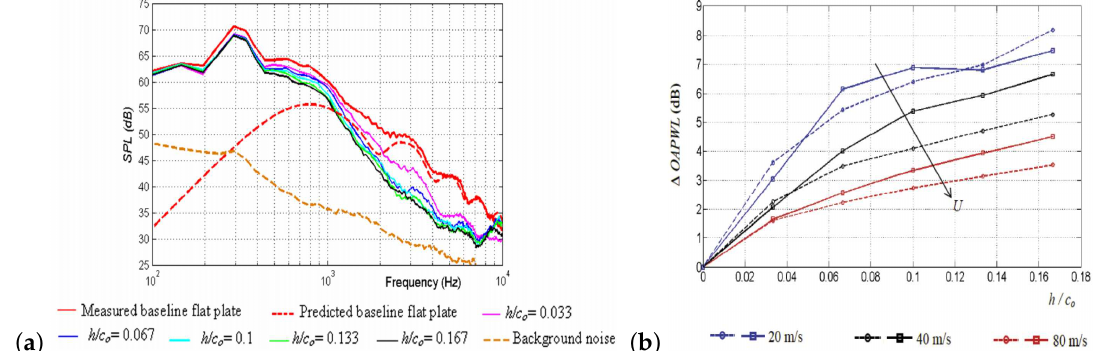
Figure 5. Typical comparison of acoustic spectra, reprinted from [63] with permission from AIP Publishing: ( a ) variation in amplitude (the prediction by using Amiet theory is shown in this subfigure to validate the measurement method and to establish the baseline acoustic spectra); and ( b ) variation in wavelength (dashed lines and solid lines for each speed denote λ = 0.033 c 0 and λ = 0.133 c 0 ,